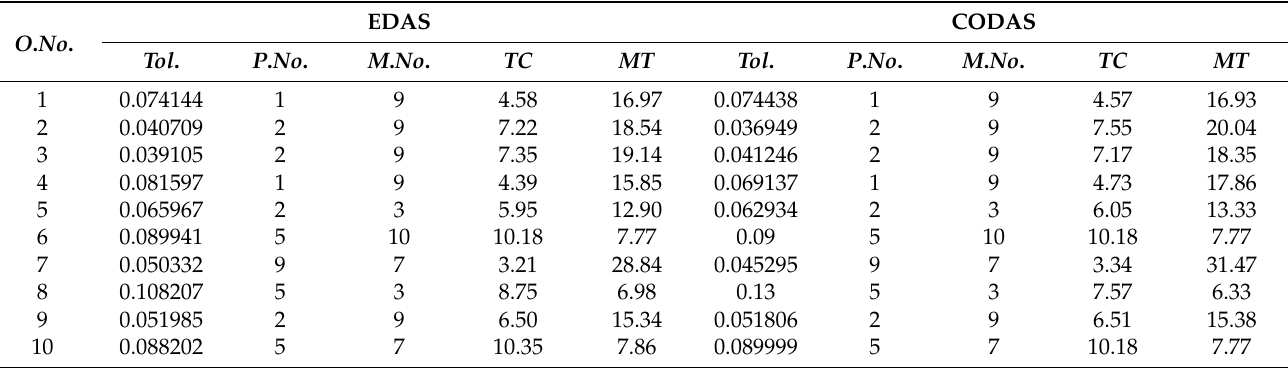
Table 12. The optimum allocated tolerance of knuckle joint